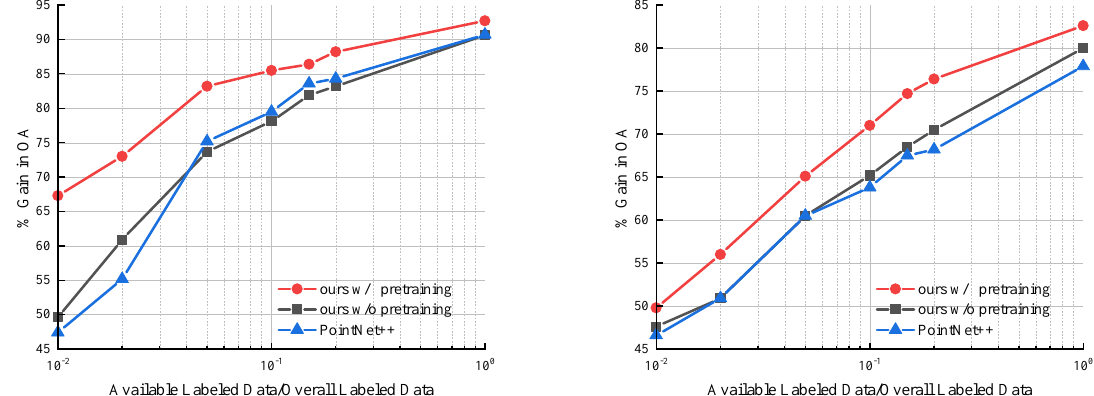
Figure 4. Evaluation results of training the network with a small amount of labeled data on Model- Net40 ( left ) and ScanObjectNN ( right ).